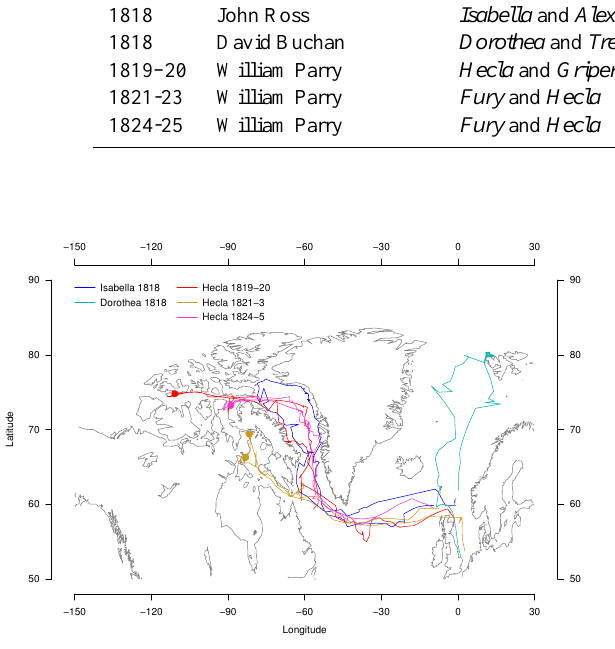
Table1. Expeditionsfromwhichobservationsweredigitised